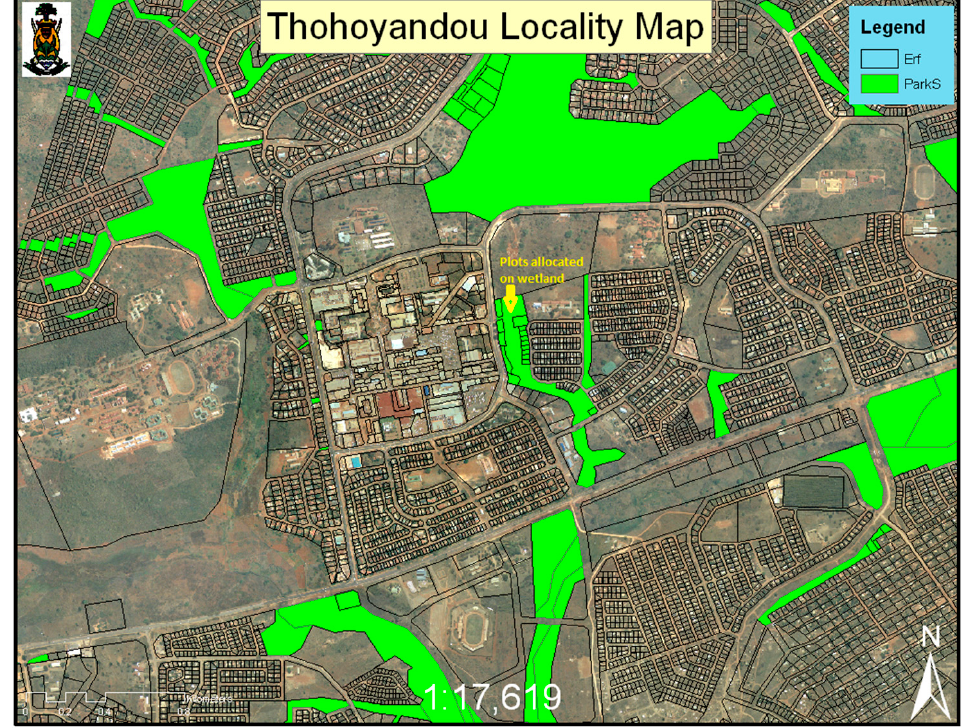
Figure 5. Allocation of residential and business stands on wetlands in Thohoyandou.